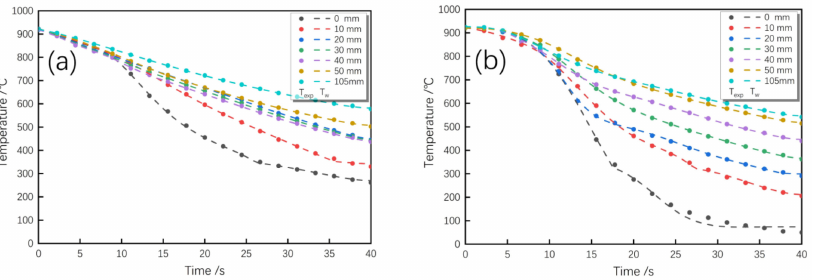
Figure 15. Temperature measurement curves. ( a ) 0.1 MPa compressed air; ( b ) 0.5 MPa compressed air mixed with dry ice